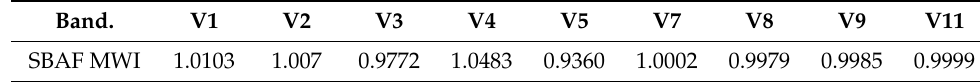
Table 3. Spectral adjustment factors between MWI and MODIS.